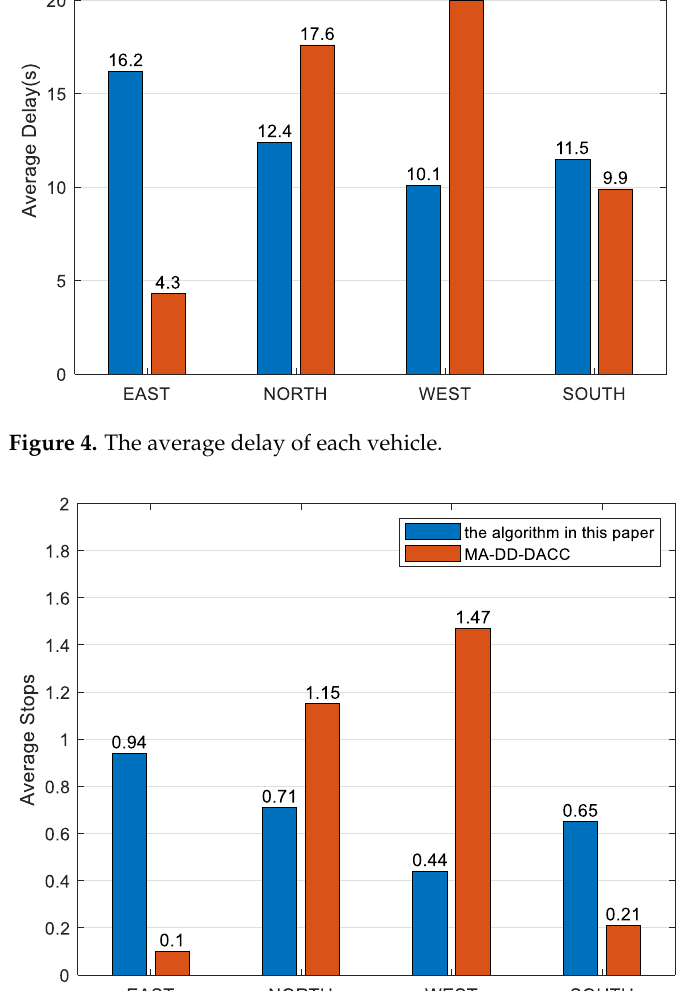
Figure 5. The average stopping times of each vehicle.